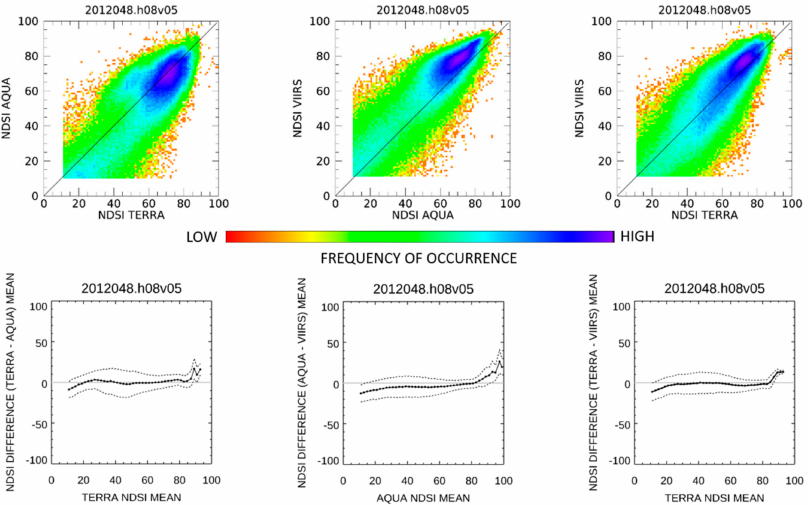
Figure 10. Cross-comparisons of 17 February 2012 for tile h08v05. MOD10A1 to MYD10A1 ( left ), MYD10A1 to VNP10A1 ( center ) and MOD10A1 to VNP10A1 ( right ). 2D histograms of cell-to-cell NDSI_Snow_Cover comparisons in the top row. NDSI_Snow_Cover mean di ff erences in the bottom row; mean is solid line and standard deviation is dashed